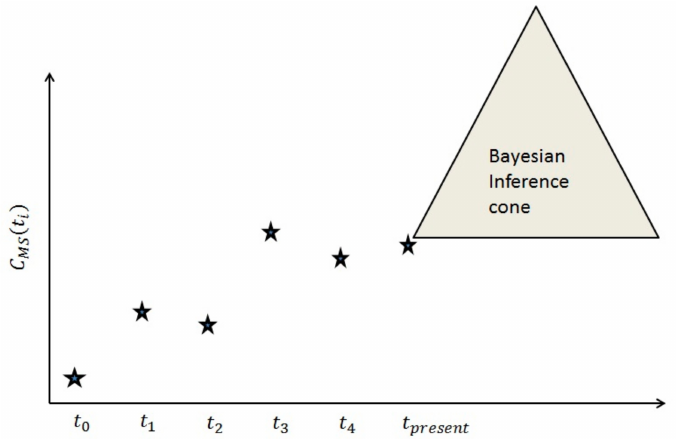
Figure 6. Hypothetical data points of C MS ( t i ) vs. time, shown with ∗ , concatenated with Bayesian